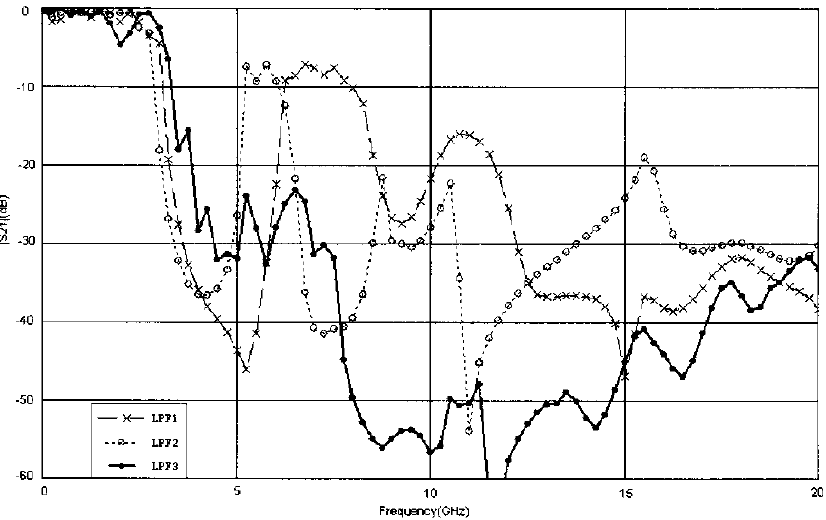
FIGURE 3 Measured results of the transmission characteristics of the